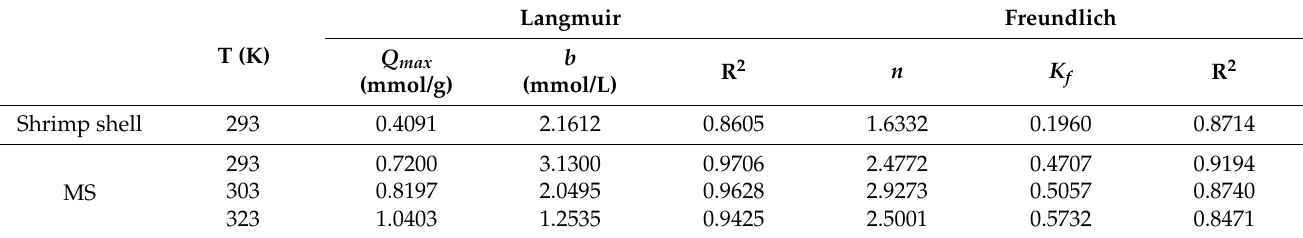
Table 4. Langmuir and Freundlich constants and correlation coefficients of Cu (II) on shrimp shell and